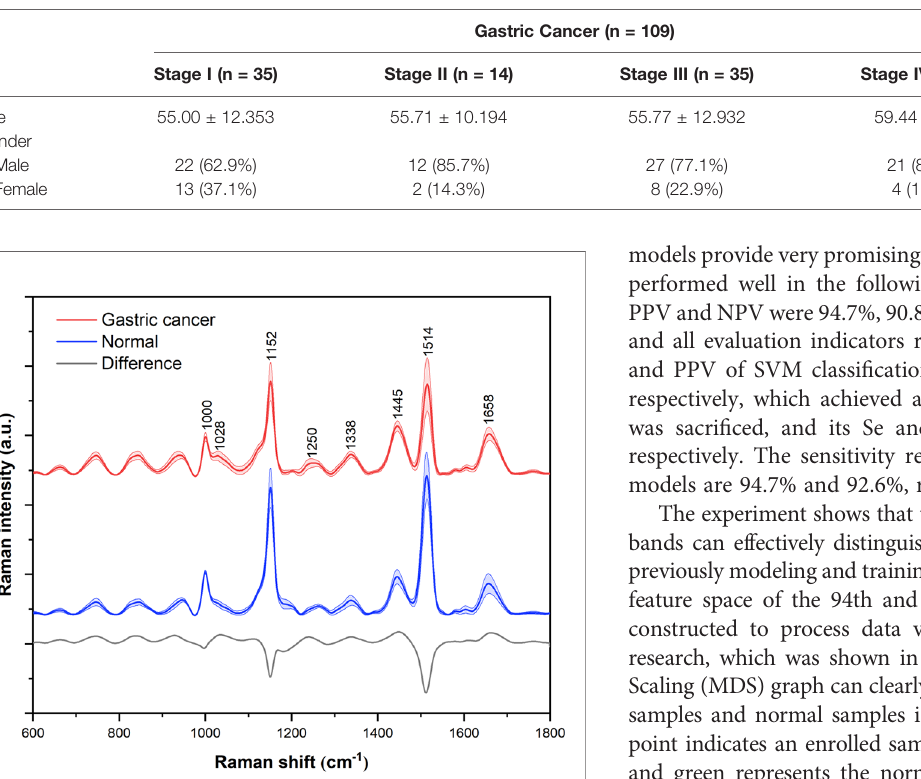
TABLE 2 | The peak position and tentative vibrational mode assignment of the serum Raman spectra. Raman shift (cm -1